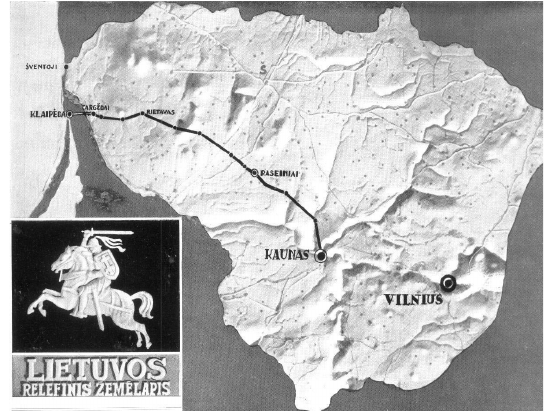
Fig 5. Relief model of Lithuania